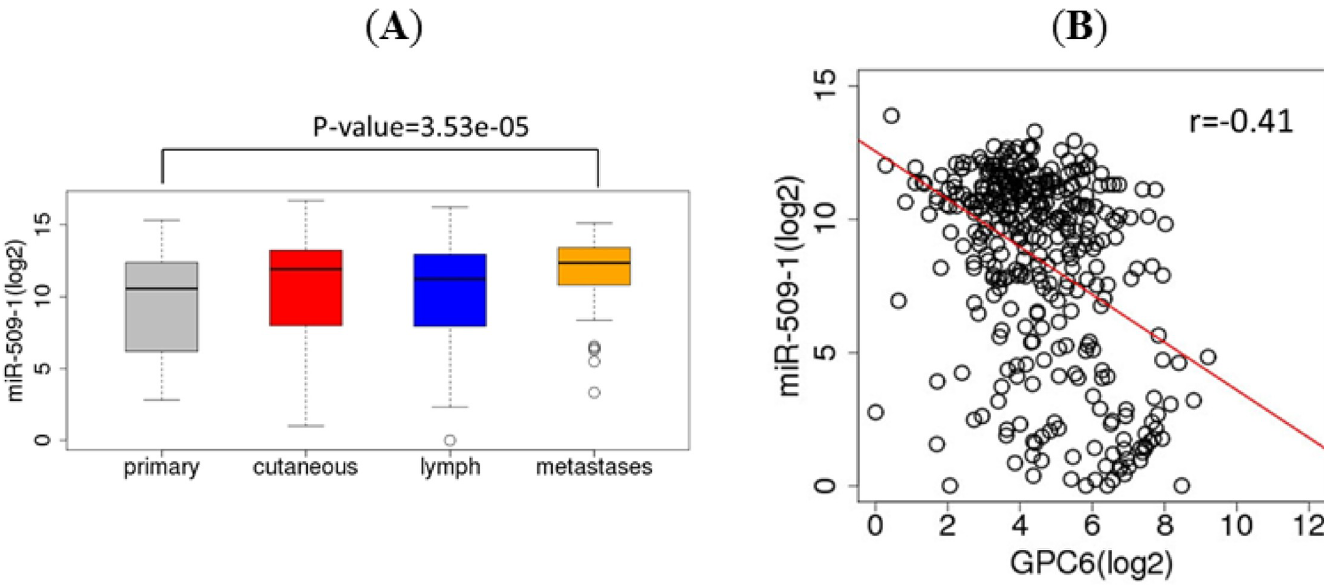
Fig 2. miR-509-1 expression and correlation with GPC6. (A) Boxplots of miR-509-1 expression levels in TCGA melanoma samples for the four tissue sites. (B) Scatter plot of miR-509-1 and GPC6 expression levels in TCGA melanoma samples (N = 389). The red line indicates the regression line.